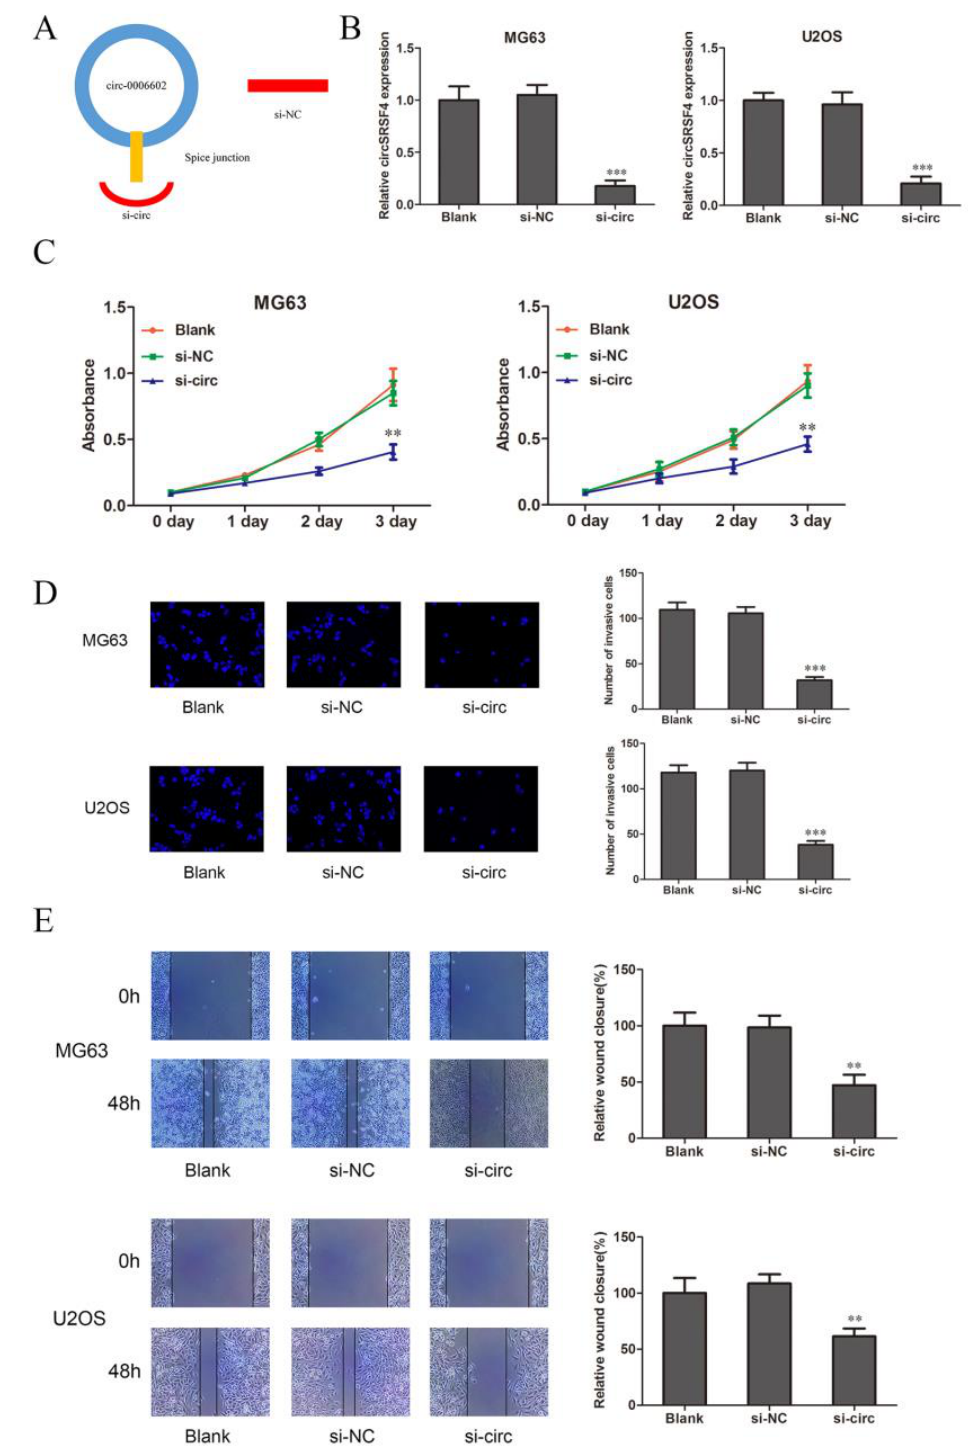
Figure 2. CircSRSF4 promotes the proliferation, migration, and invasion of OS cells. ( A ) Structure of circSRSF4 siRNA. ( B ) Expression of CircSRSF4 in OS cells transfected with circSRSF4 siRNA. ( C – E ) The proliferation activity, invasion, and migration ability of transfected cells were detected by CCK-8 assay, transwell assay, and scratch wound healing assay. ** p < 0.01, *** p < 0.001. As a competitive endogenous RNA (ceRNA), circular RNA can combine with specific miRNAs and regulate the expression of miRNAs as a miRNA sponge [25,26]. According